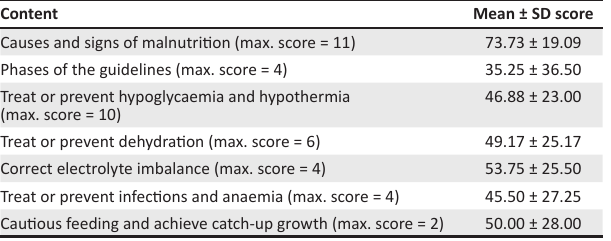
TABLE 2: Nurses’ mean knowledge scores according to the seven topics assessed ( n = 104). Content